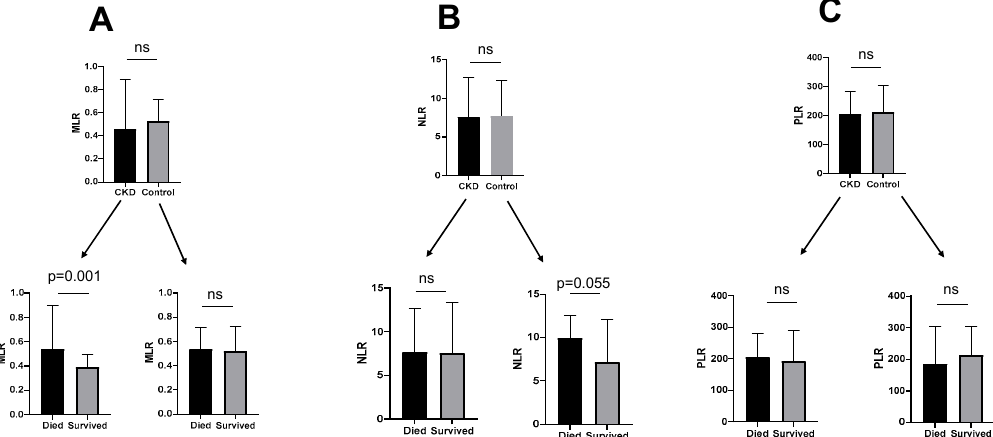
Figure 2. MLR ( A ), NLR ( B ), and PLR ( C ) among patients admitted with CKD (chronic kidney disease) or without CKD (control) that were admitted with the diagnosis of COVID-19. Among patients with CKD, levels of MLR were higher in the deceased patients than in those who survived (( A ), lower panel). NLR levels were somewhat higher in patients without CKD (control) who died in hospital compared with those who survived (( B ), lower panel). PLR values did not correlate with the survival outcome in both groups ( C ). ns: non-significant. NLR (neutrophil to lymphocyte ratio), PLR (platelets to lymphocyte ratio), MLR (monocytes to lymphocyte ratio).